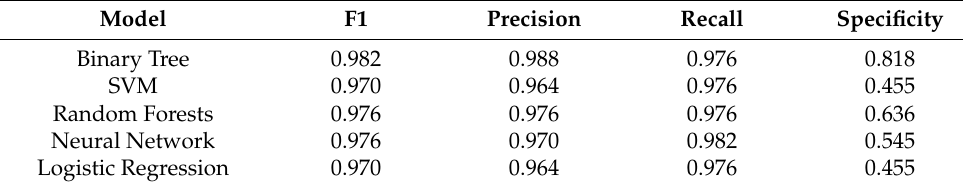
Table 14. Models accuracy metrics for not adding product from recommending interface (class 0) with add_to_cart_ direct as target